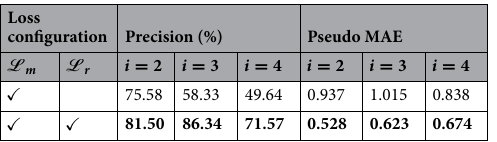
Loss configuration Precision (%)